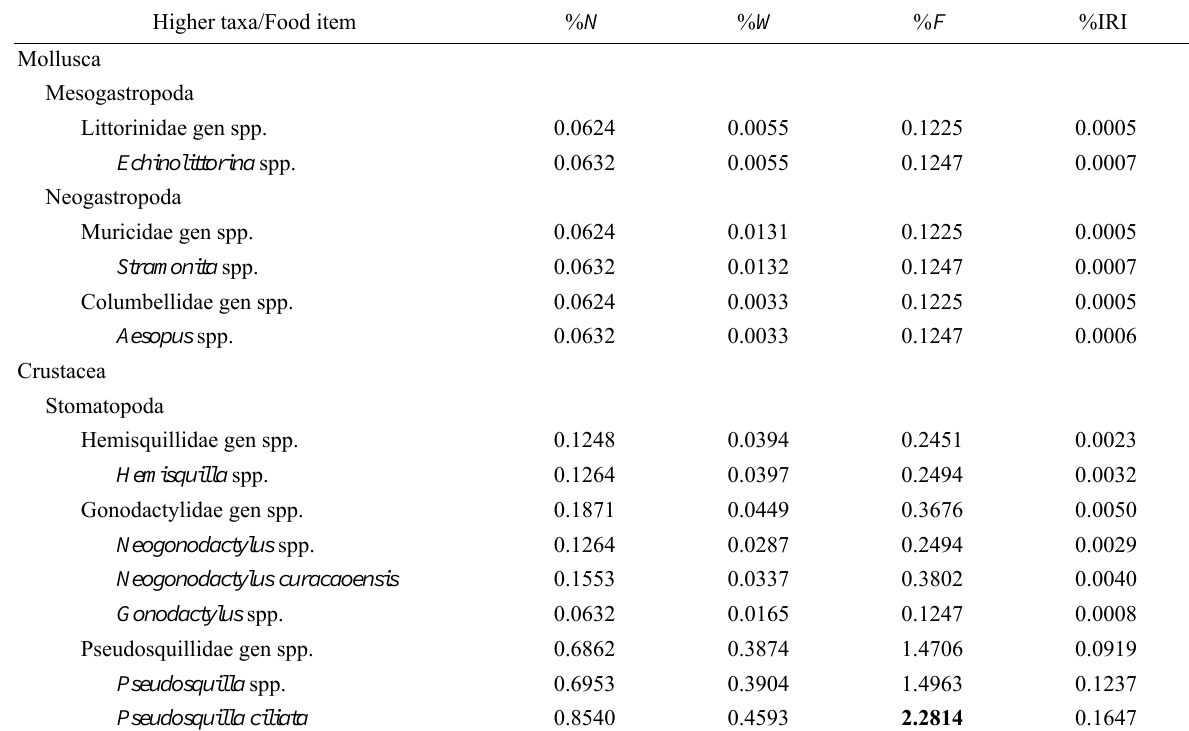
List of food items (prey consumed) found in the stomach contents of red lionfi sh, Pterois volitans , collected in the Mexican